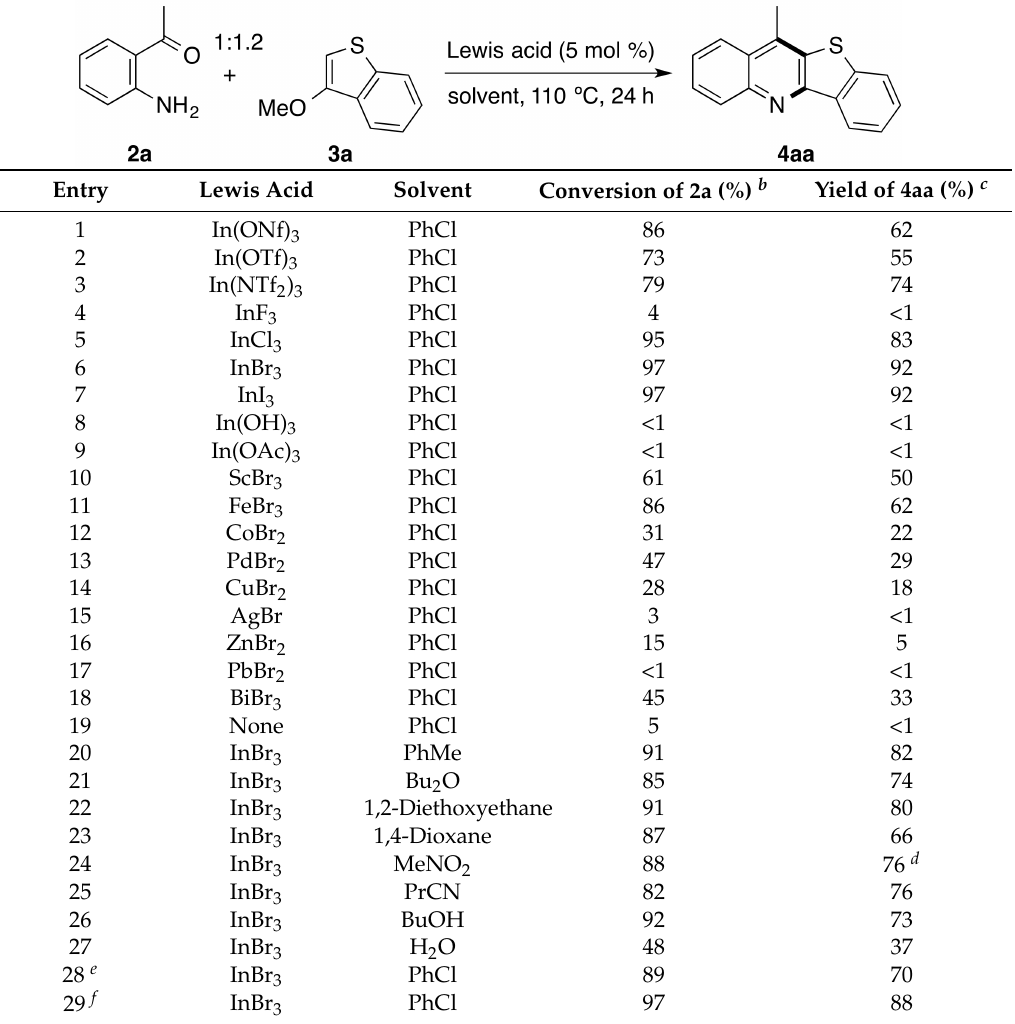
Table 2. Lewis acid-catalyzed annulation of o -acetylaniline with 3-methoxybenzothiophene a